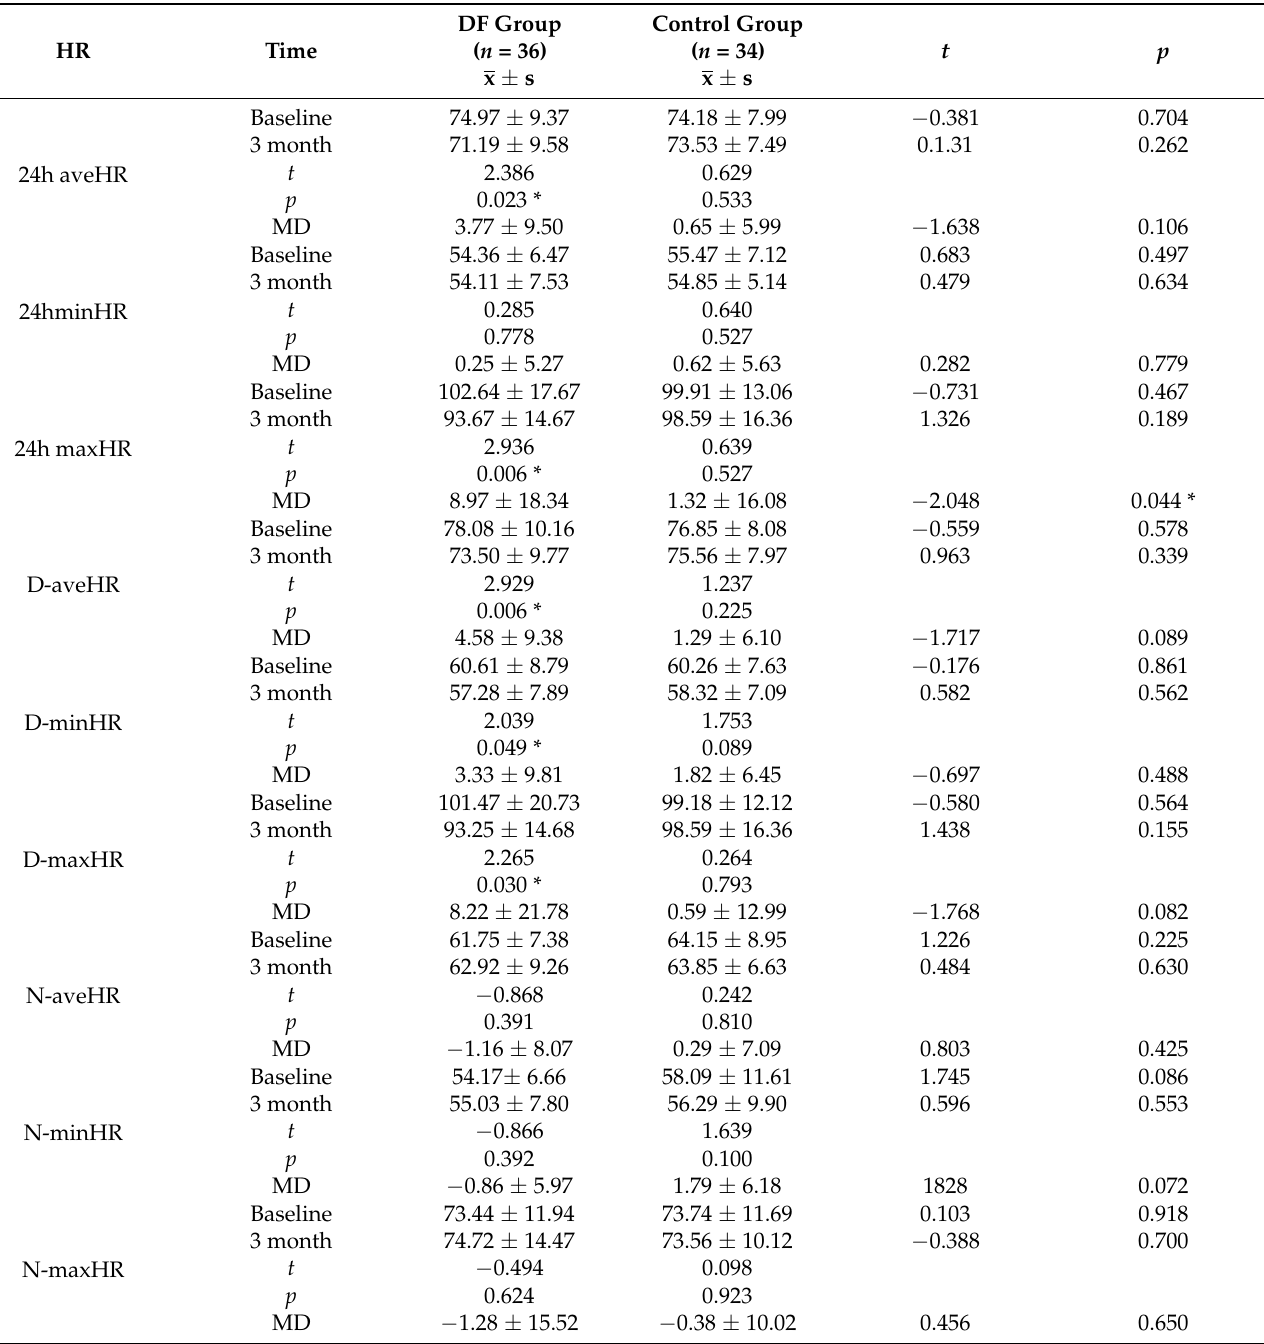
Table 5. Intention-to-treat analysis of comparison of HR between/within two